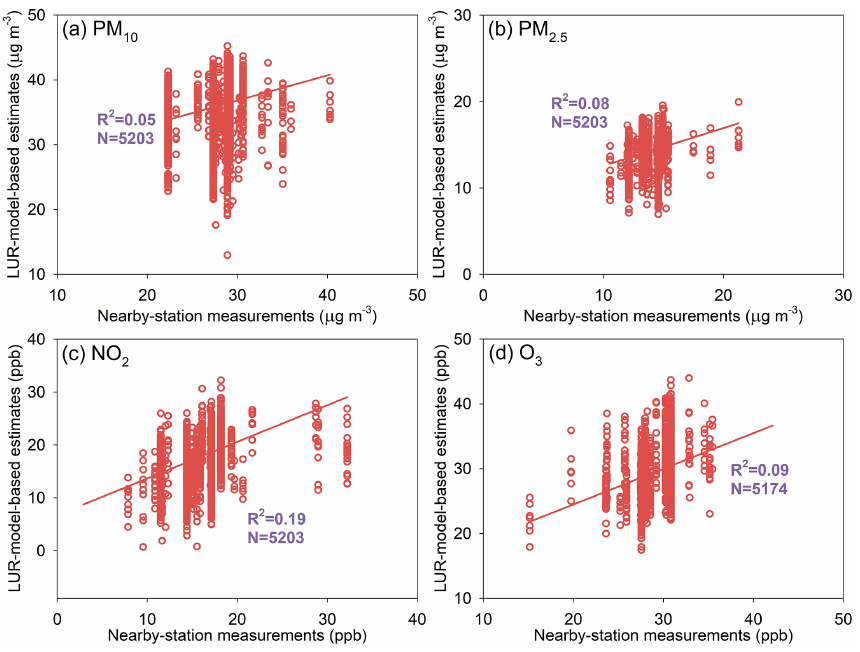
Figure 6. The linear regression of nearby-station air pollutant measurements and LUR-model-based air pollutant concentration estimates. (a) PM 10 , (b) PM 2 . 5 , (c) NO 2 and (d) O 3